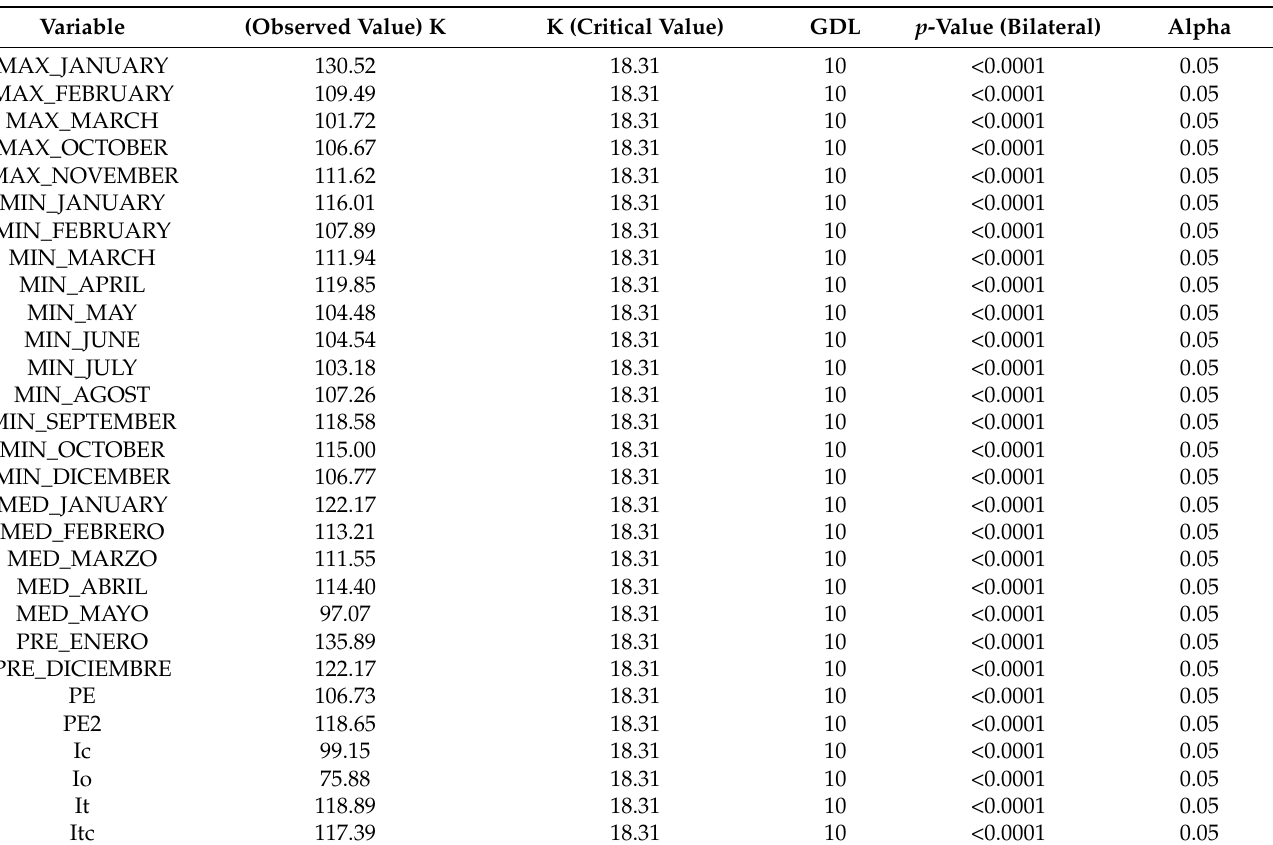
Table 2. Analysis of means by Kruskal-Wallis test of the selected bioclimatic variables associated with each sampling